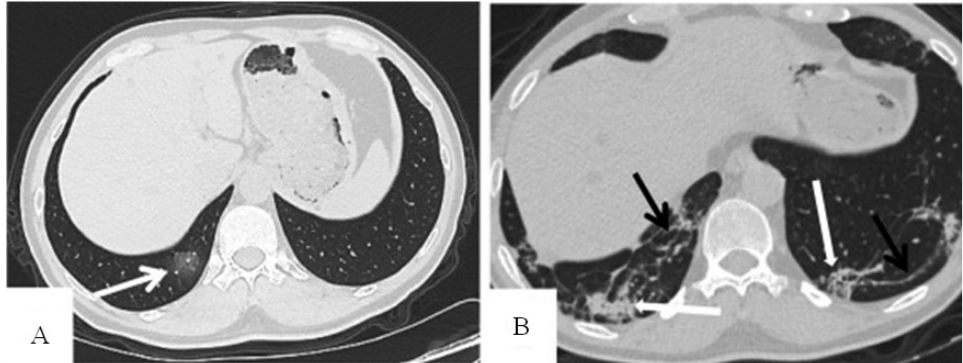
Figure 4. “Male, 48 years, transverse thin-section CT scan. ( A ) 4 days after the onset of initial symptoms: subpleural GGO (arrow) in the right lower lobe. ( B ) 38 days after the onset of initial symptoms: There was no significant change in the extent and composition of lesions compared with the directly prior CT result, with consolidation (thick white arrow) and linear opacities (thin black arrow) in the right lower lobe, and crazy-paving pattern (thick white arrow) and linear opacities (thin black arrow) in the left lower lobe” [36] .